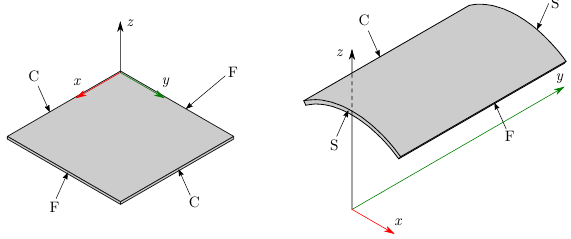
Figure 3. Examples of boundary conditions for open geometries.